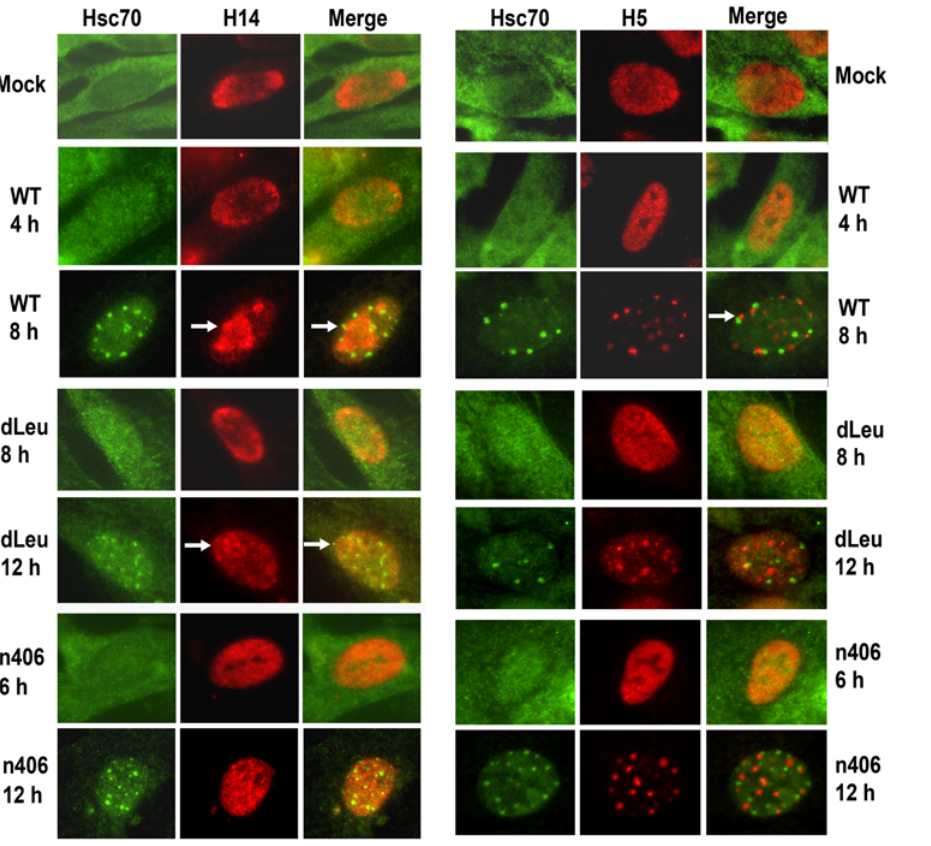
Figure 7. Hsc70 Nuclear Sequestration Correlates with the Loss of Phospho-serine 2 Form of RNAP II CTD in Fully Formed Replication Compartments. Vero cells were mock-infected or infected with WT HSV-1, dLeu or n406 for the times indicated. In the left hand panels, cells were stained with anti-RNAP II antibody, H14, which recognizes phospho-serine 5 RNAP II CTD, and anti-Hsc70 antibody. Arrows show a replication compartment with an Hsc70 focus site at the periphery in the 8 h WT-infected cell, and a pre-replication site (red) next to a small Hsc70 focus site (merge) in the 12 h dLeu-infected cell. In the right panels, cells were stained with anti-Hsc70 antibody and anti-RNAP II antibody H5, which recognizes phospho-serine-2 RNAP II CTD. This antibody also cross-reacts with a phospho-epitope in splicing SR proteins [11,40]. The arrow points to an Hsc70 focus site (green) adjacent to a splicing speckle (red).